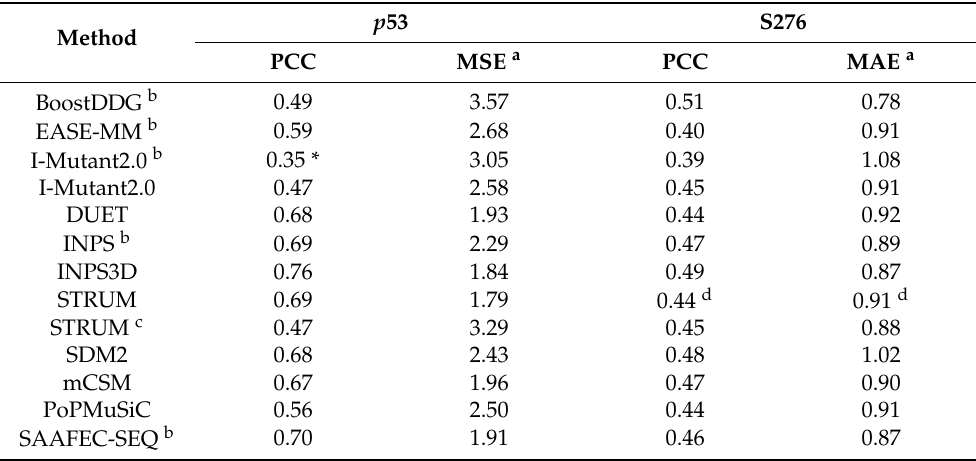
Table 2. Comparison of different methods on the p 53 and S276